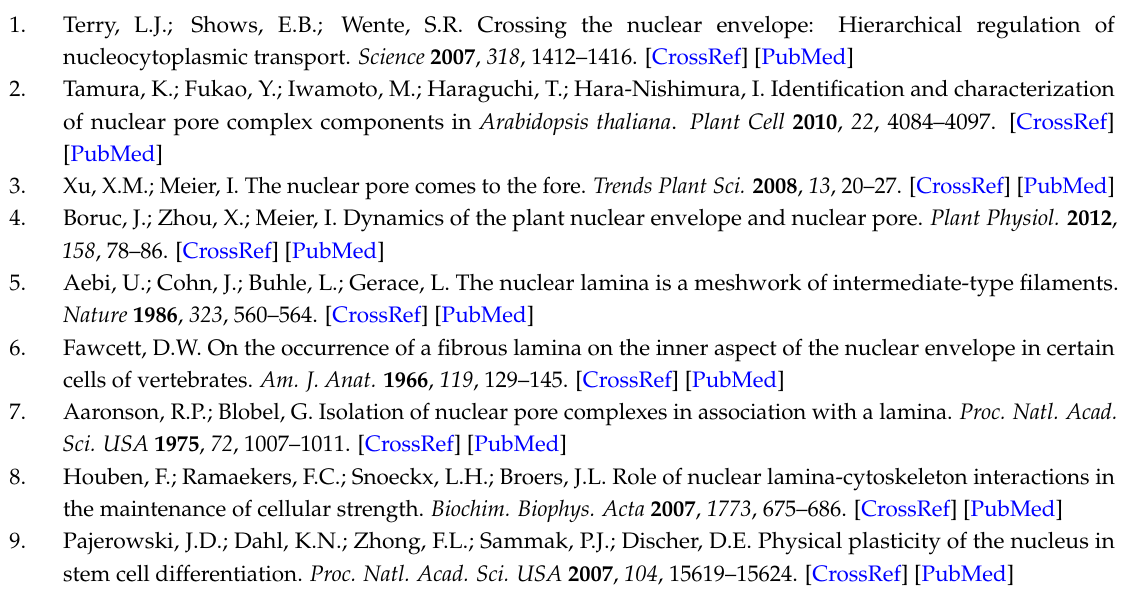
Figure S1: eGFP::pUL50 construct and Western blot detection, Figure S2: pUL53::tagRFP construct and Western blot detection, Figure S3: CoIP constructs, Figure S4: RISP::tagRFP construct, Figure S5,S6: Regions of interest used for statistical